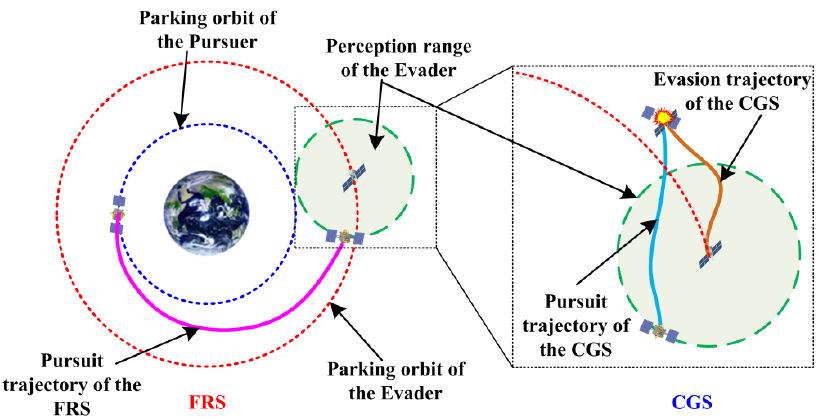
Figure 1. Illustration of FRS and CGS for a practical space PE game mission.